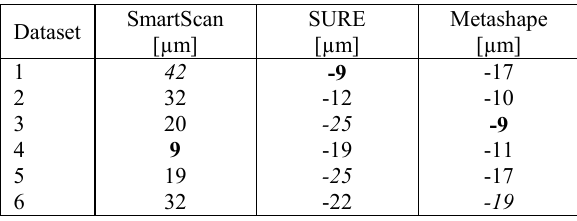
Table 5. Quality parameter sphere spacing error